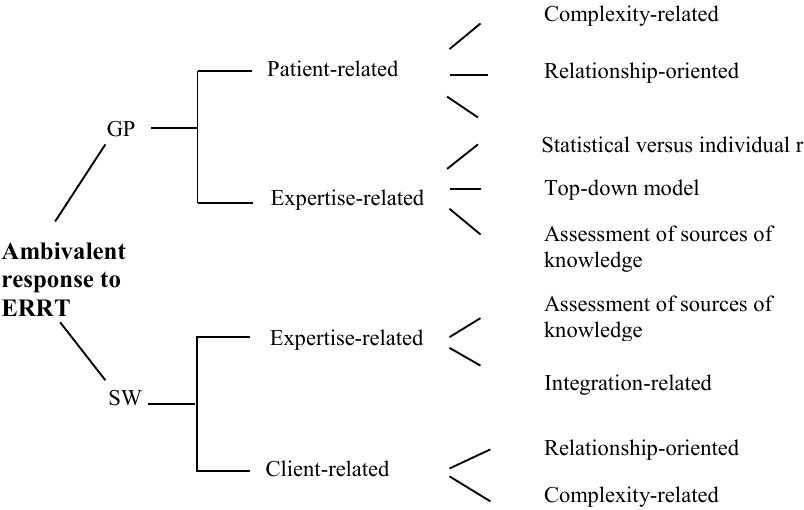
Figure 2. General practitioners’ and social workers’ ambivalent response to ERRT Compared to the SWs, the GPs tended to demonstrate a greater level of scepticism towards ORRT, which were seen to contribute to circumscription of the profession’s discretion and jurisdiction. The fear of ORRT eroding discretion and jurisdiction was not as apparent among SWs. Rather, there was a tendency among SWs to view ORRT as something that might contribute to clarifying jurisdiction within their professional practice and protecting the individual SW from